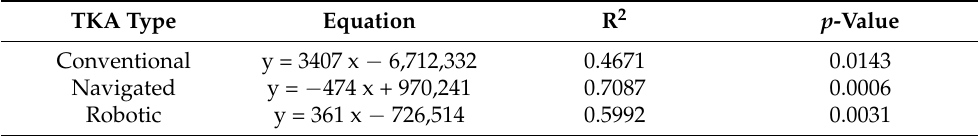
Table 1. Regression analysis for three different types of TKA (conventional, navigated and robotic) per- formed in Germany between 2010 and 2021 (complementary table to Figure 1). The level of significance is shown in the last column ( p -value) and demonstrates if each slope is significantly